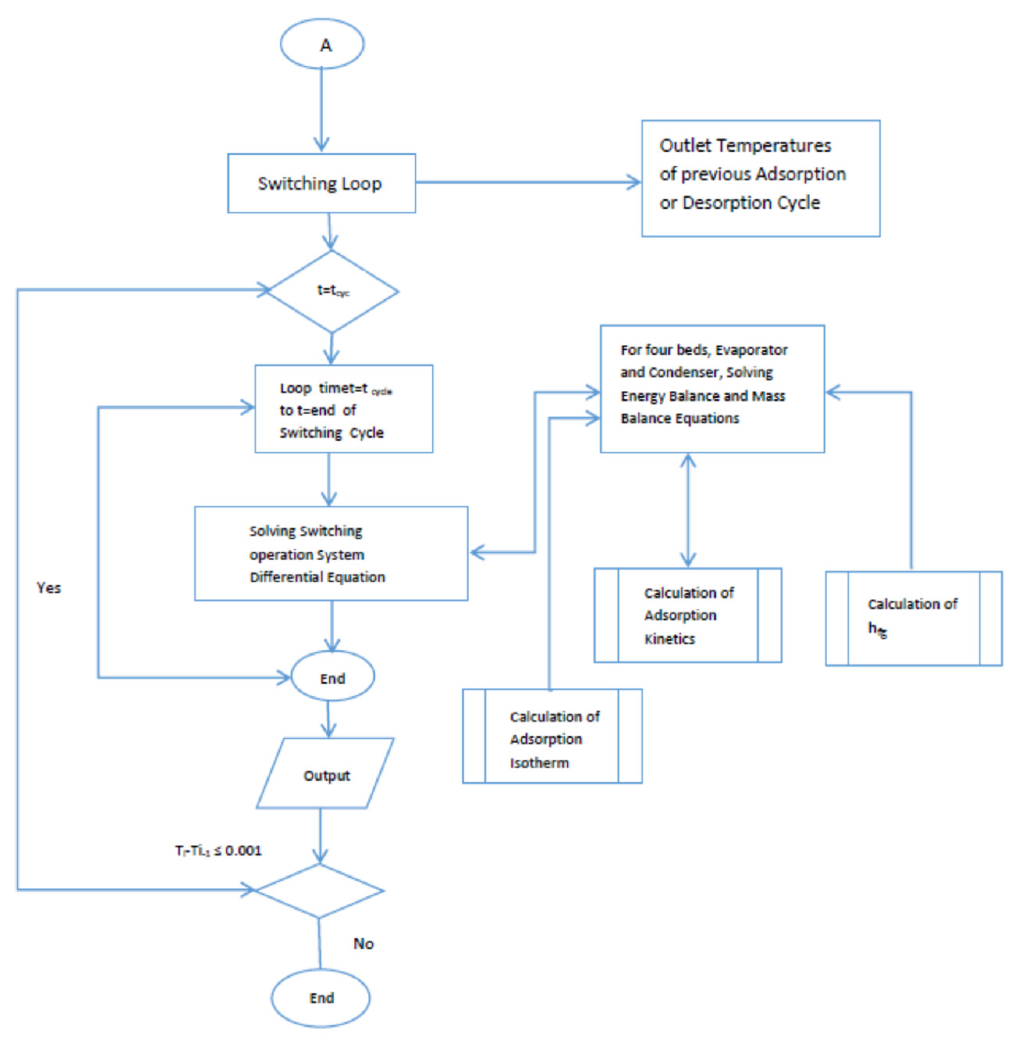
Figure A2. Flow chart for the simulation, Continue. Table A1. Parameters Used in